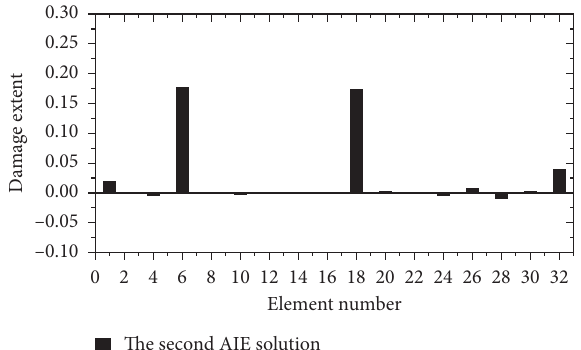
Figure 8: Damage assessment result by the second AIE when elements 6 and 18 are damaged.